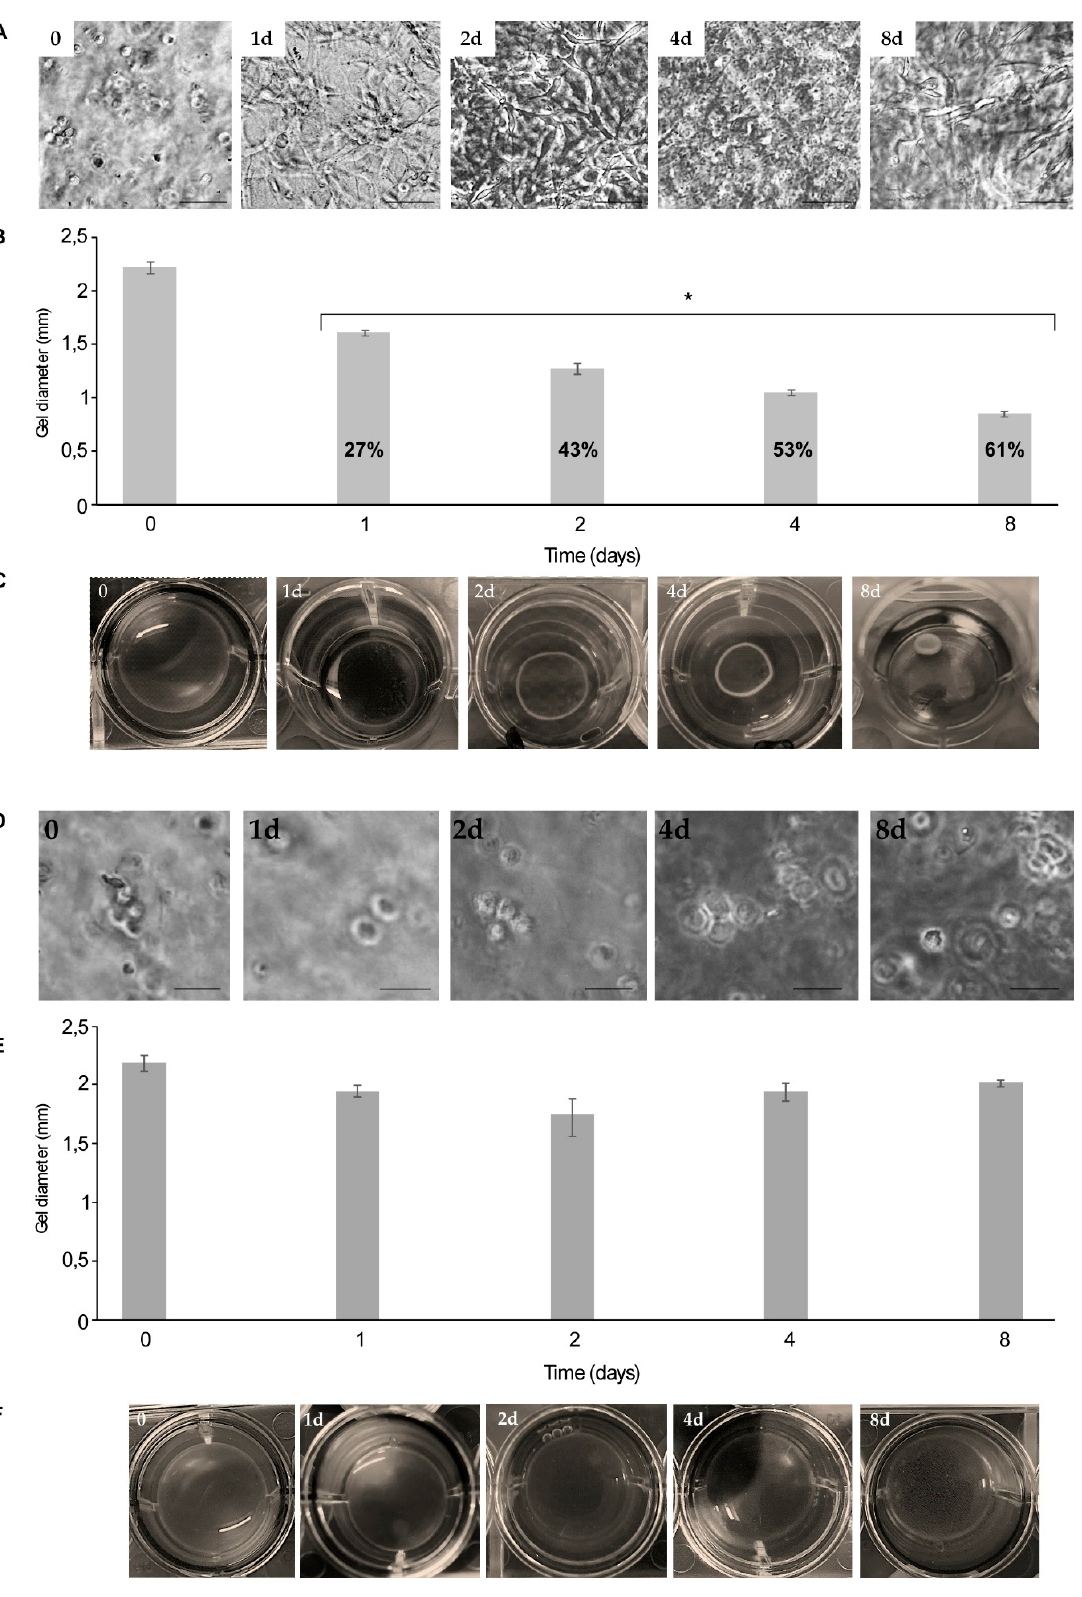
Figure 5. Performance of Rat Tail Collagen hydrogel (RTCh) and MCh in the maintenance of chondrocytes. ( A ) Growth of bovine nasal chondrocytes (NCs), time 0 control (0) and growth within RTCh, respectively, for 1 (1d), 2 (2d), 4 (4d) and 8 days (8d). Magnification was 20×; scale bar was 25 μ m. NCs remodeled RTCh (type I collagen) from the first day of culture; this was indicated both by